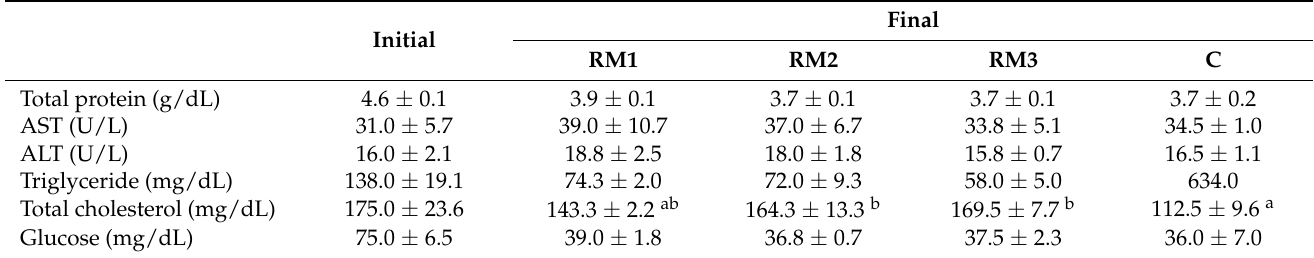
Table 12. Plasma constituents in fish under different treatments in Trial